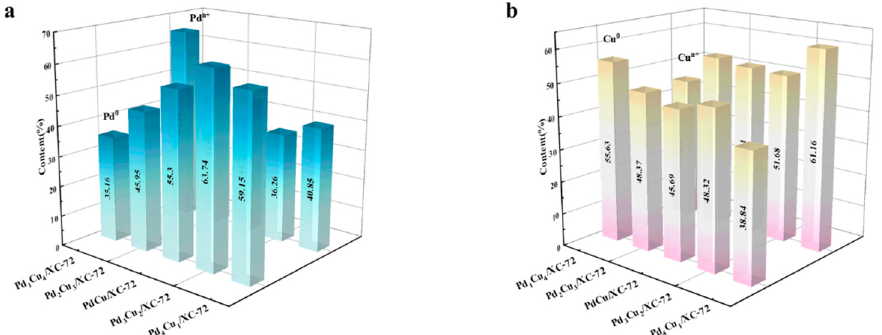
Figure 5. ( a ) The corresponding Pd 0 and Pd n+ contents of Pd 1 Cu 4 /XC-72, Pd 2 Cu 3 /XC-72, PdCu/XC- 72, Pd 3 Cu 2 /XC-72, and Pd 4 Cu 1 /XC-72, as well as ( b ) the corresponding Cu 0 and Cu n+ contents of Pd 1 Cu 4 /XC-72, Pd 2 Cu 3 /XC-72, PdCu/XC-72, Pd 3 Cu 2 /XC-72, and Pd 4 Cu 1 /XC-72.